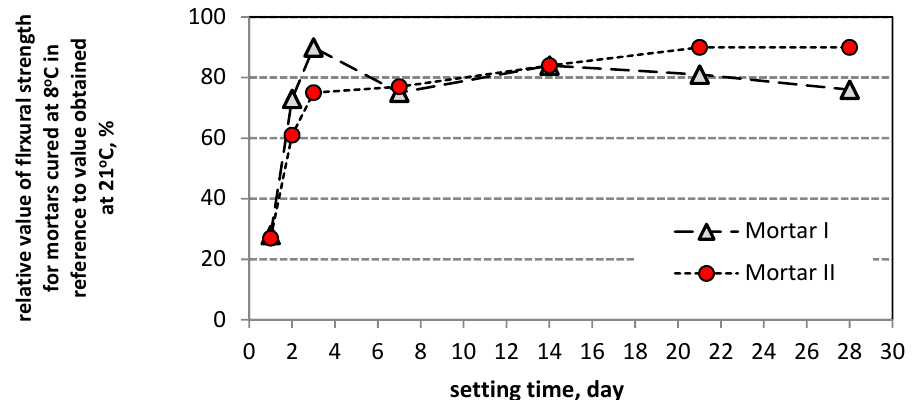
Figure 10. Flexural strength increase rate of mortars cured at 8 ° C, in reference to the values obtained in the same period for mortar setting at 21 ° C.